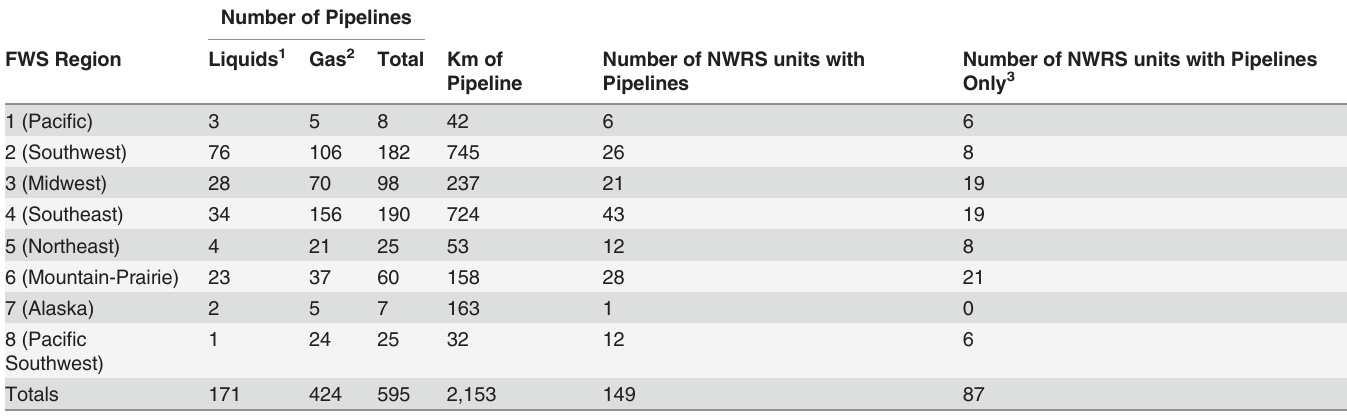
Table 6. Number of pipelines crossing NWRS